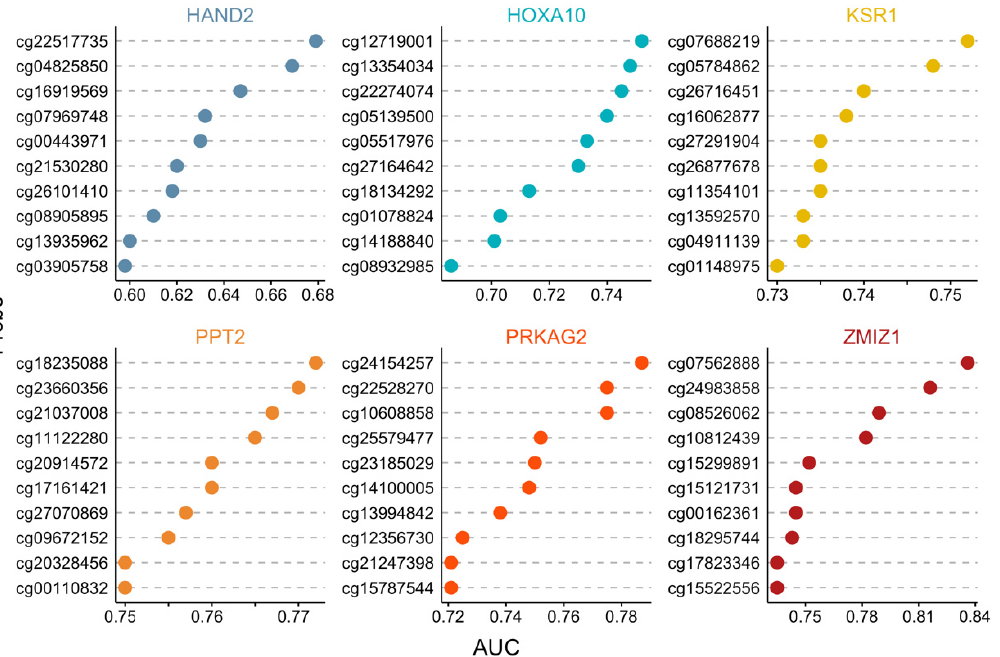
Figure 2. The AUC of top 10 probes of differentially methylated CpG sites in cervical secretion samples from 24 pregnant and 17 non-pregnant subjects with MethylationEPIC BeadChip array.